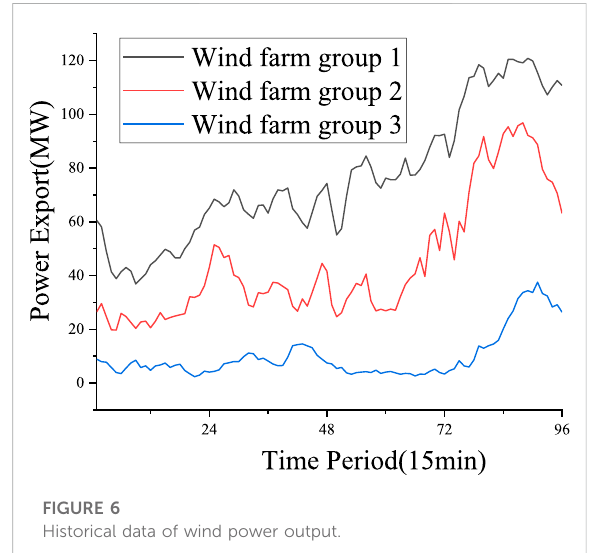
FIGURE 6 Historical data of wind power